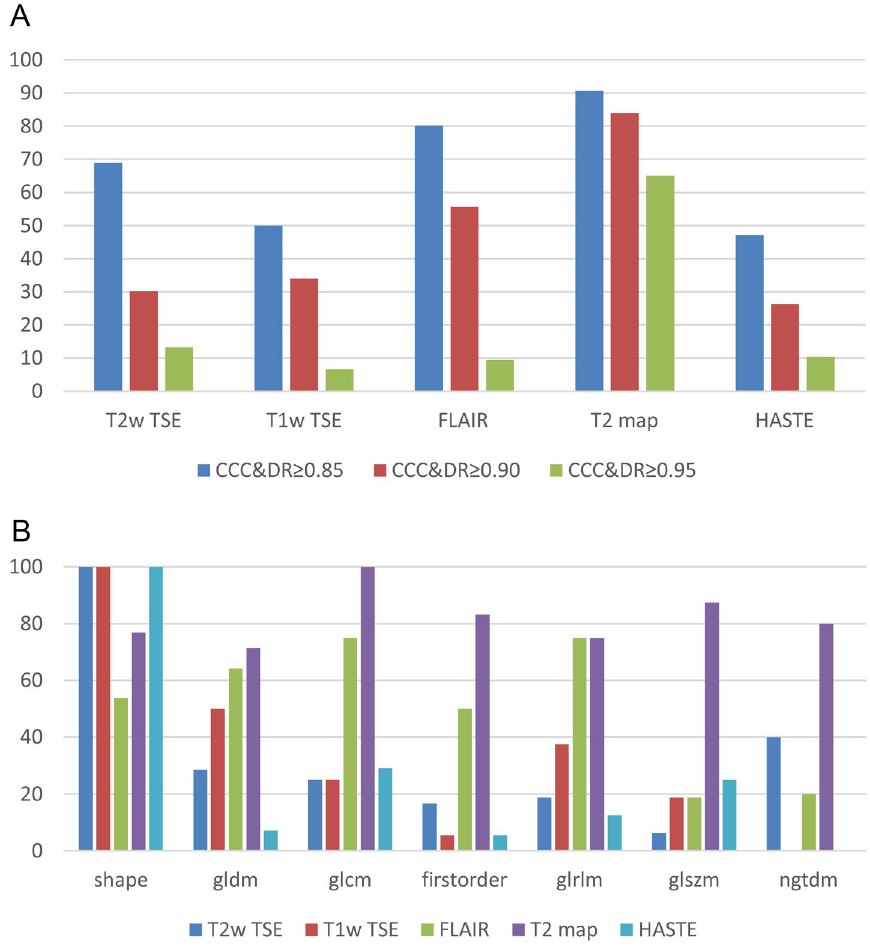
Figure 2. Impact of MRI sequences on the amount of robust features. Concordance correlation coefficient (CCC) and dynamic range (DR) values were computed for each feature and depicted for each MRI sequence ( A ) and feature class ( B ). The fraction of features decreases reciprocally to higher levels of robustness (CCC & DR ≥ 0.85; ≥ 0.90; ≥ 0.95) with T2 map revealing highest stability ( A ). We depict the distribution of excellently robust (CCC & DR ≥ 0.90) features in B. T2 map yields the highest fraction of robust features ( A , B